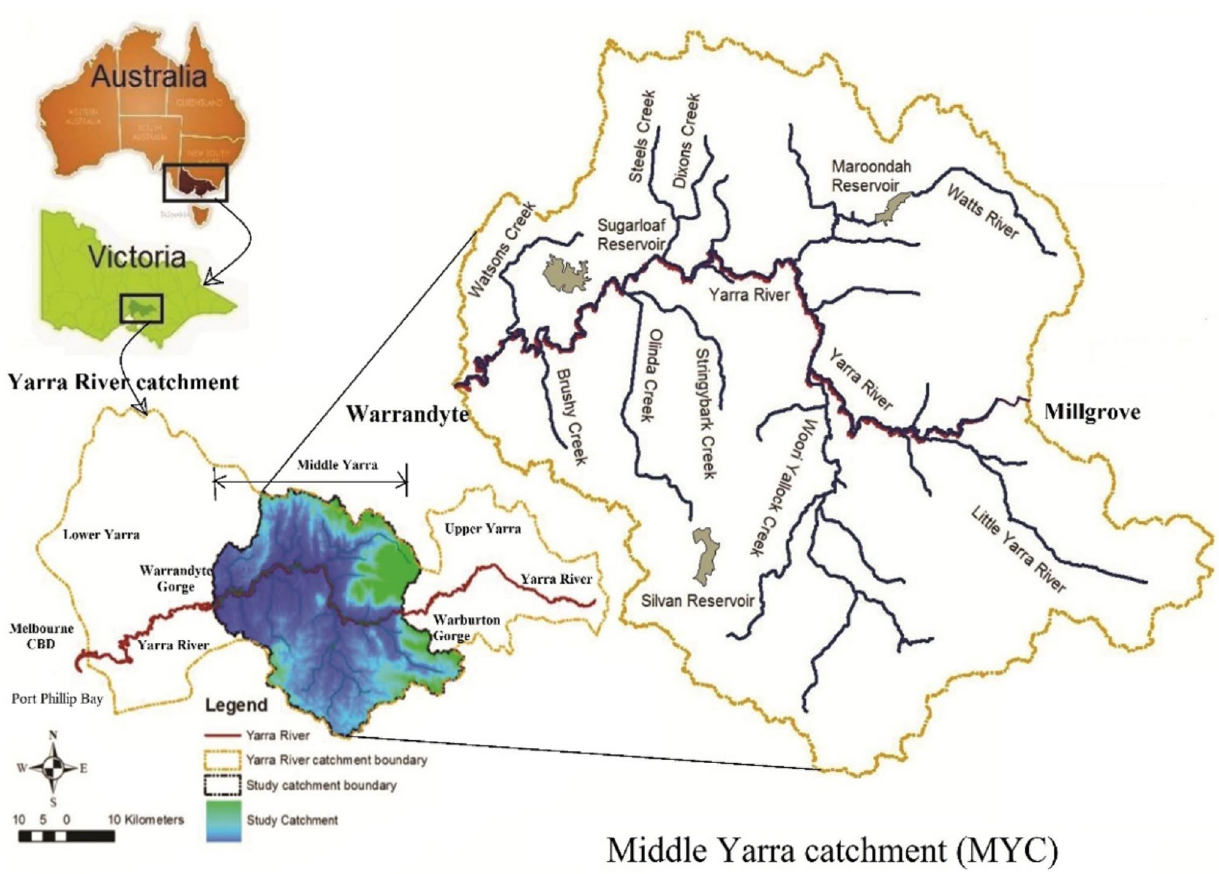
Fig. 1 The Middle Yarra Segment